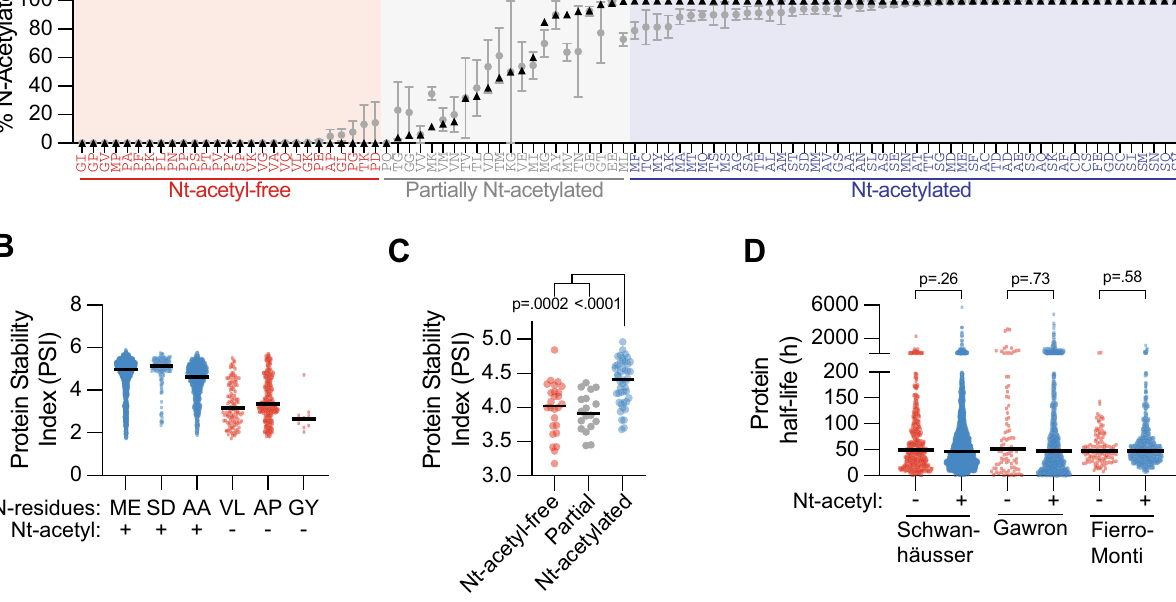
Figure 1. Nt-acetylation correlates with increased stability in case of a modified GFP protein, but this correlation does not apply to all human proteins. ( A ) Three proteome-wide Nt-acetylation studies were mined to extract the average percentage of Nt-acetylation for each detected protein. Subsequently, proteins with identical N-terminal dipeptide sequences were grouped. Plotted are the median (black triangles) and mean ± SEM (grey circles) percentages of Nt-acetylation for each dipeptide sequence group. Only dipeptide sequence groups for which at least two different substrates were detected by the combined Nt-acetylation studies were included. ( B ) Protein stability, as indicated by the Protein Stability Index (PSI), was determined for ~ 50,000 GFP variants that differ with regards to their N-terminal sequence (Timms et al.) 26 . Sequence variants carrying the indicated N-terminal dipeptide sequences were grouped, and the PSI score for each variant was plotted. Black line indicates the median. ( C ) All GFP variants from Timms et al. were grouped according to the N-terminal dipeptide sequence, divided into Nt-acetylation susceptibility bins, and the average PSI score for each group was plotted. Black line indicates the median (Kruskal–Wallis ANOVA, post-hoc Dunn’s). ( D ) The proteins detected in the proteomic studies of Schwanhäusser et al. 2 , Gawron et al. 22 , and Fierro-Monti et al. 30 were divided into Nt-acetyl-free or Nt-acetylated groups, based on their N-terminal dipeptide sequence and associated Nt-acetylation susceptibility as described in panel A. For each protein the half-life determined by the indicated studies was plotted. Black line indicates the median (Kolmogornov–Smirnov